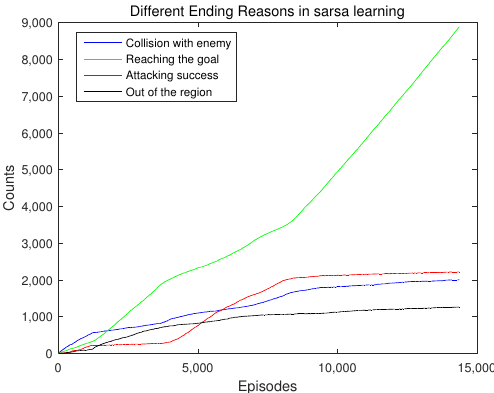
Figure 9. The numbers of different ending reasons in the policy